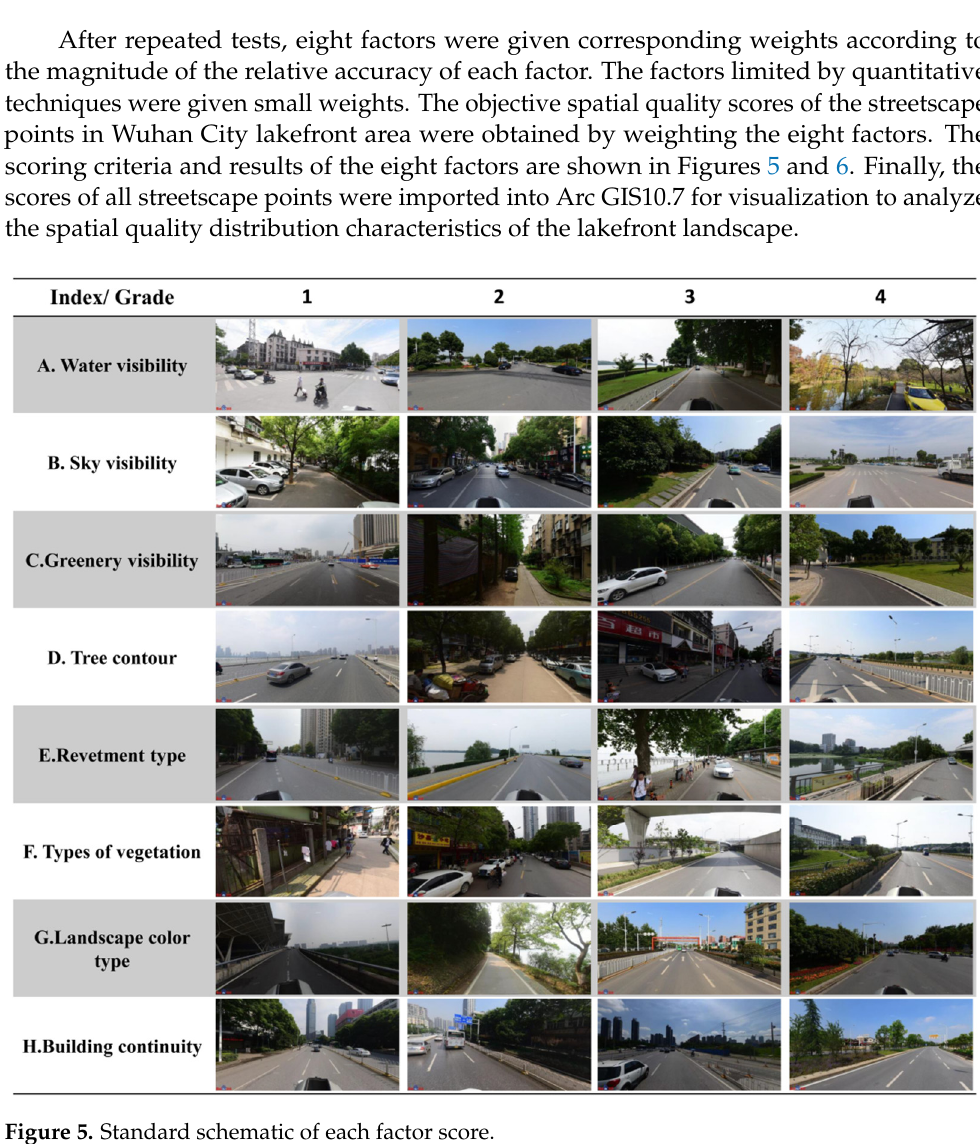
Figure 5. Standard schematic of each factor score.